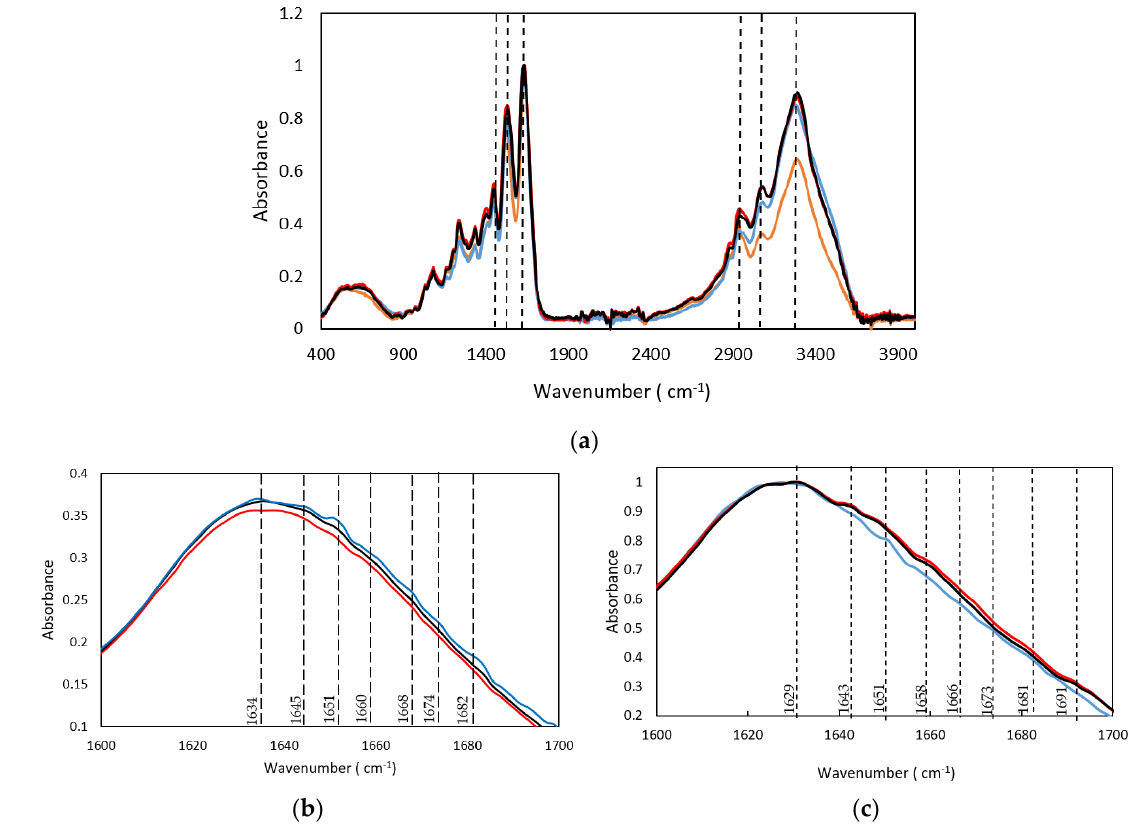
Figure 6. ( a ) FTIR spectra at 50 °C, ( b ) FTIR spectra at room temperature and ( c ) FTIR spectra at 50 °C; in the 1600–1700 cm − 1 region of ( - ) Dry GE, ( - ) 25GE, ( - ) 25GE/DOX and ( - ) 25GE/Crocin.